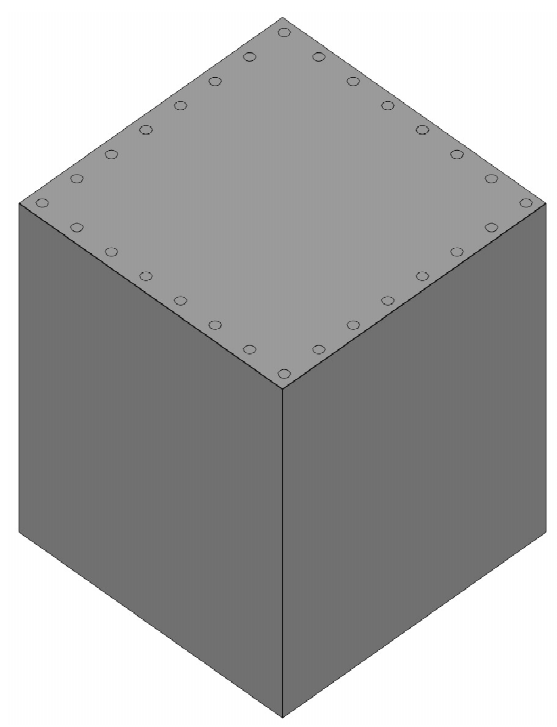
Figure 7. CAD of a column with steel-reinforced concrete.